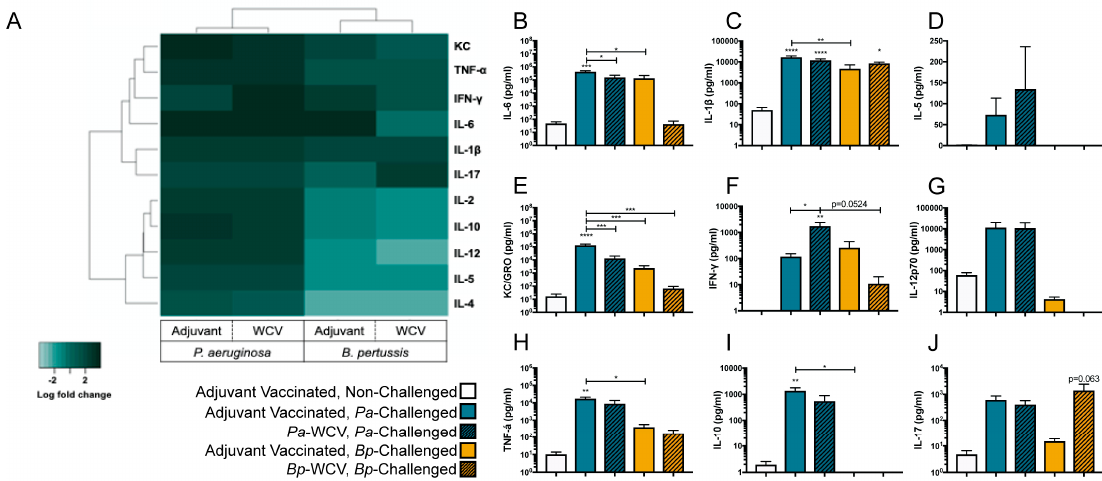
Figure 5. Cytokine and T cell response to infection following whole cell or adjuvant only vaccination. Cytokines were quantified in the lung homogenate supernatant following challenge, using the Meso Scale Discovery’s V-Plex Plus Pro-Inflammatory Panel 1 mouse multiplex assay kit, and Meso Scale Discovery’s mouse IL-17 Ultra-Sensitive kit. ( A ) Heatmap showing the log (fold change) of cytokines in each group compared to adjuvant-vaccinated non-challenged mice. Color represents an increase (dark green) or decrease (light green). ( B – J ) Cytokines measured by multiplex assay. White bars indicate the adjuvant vaccinated, non-challenged group; gold bars indicate the adjuvant vaccinated, B. pertussis challenged group; gold bars with diagonal lines indicate the Bp- WCV group; blue bars indicate adjuvant vaccinated, P. aeruginosa challenged group; and blue bars with diagonal lines indicate the Pa- WCV group. Asterisks over bars indicate comparison to adjuvant vaccinated, non-challenged group, and asterisks over brackets indicate comparisons between groups. Statistical significance determined by ANOVA: * p ≤ 0.05, ** p ≤ 0.01, *** p ≤ 0.001, **** p ≤ 0.0001.